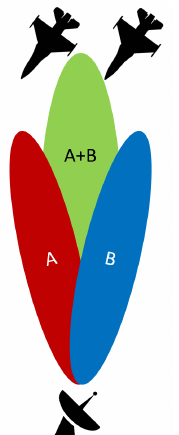
Figure 3. The formation jamming scenario, with two jammers indicated by the aircraft icons, and a monopulse tracking radars beams shown in a single plane. The A and B beams are used for amplitude comparison, and the sum beam location is indicated by A + B